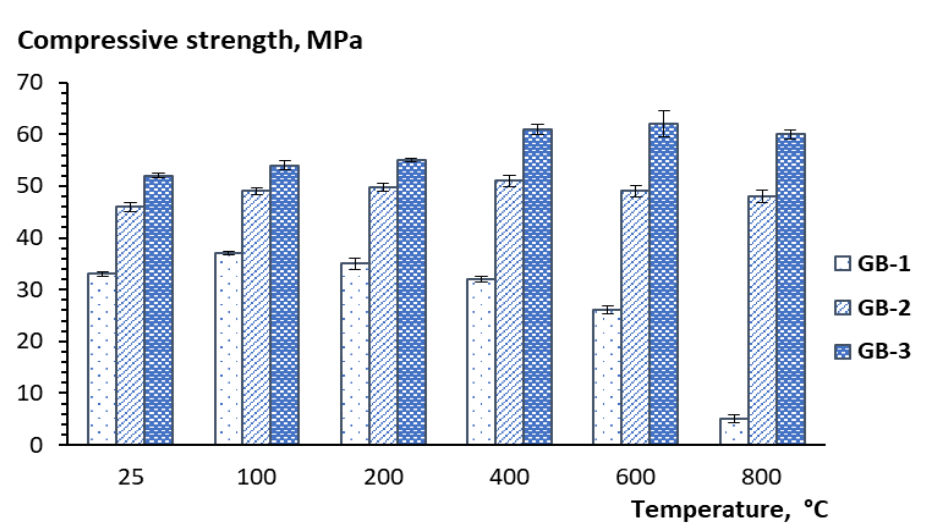
Figure 6. Temperature dependence of strength performance of alkali-activated binders.